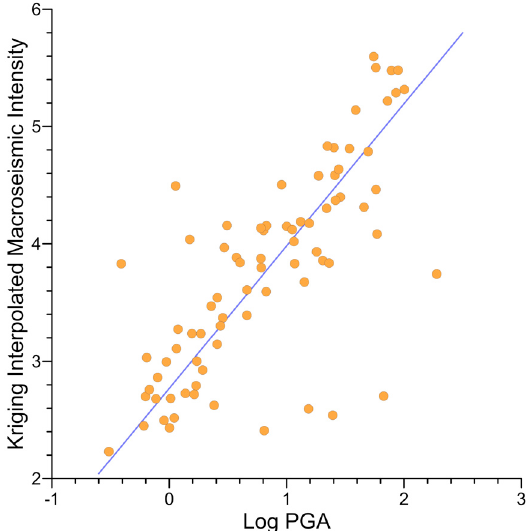
Figure 6. Scatter plot of logPGA values versus corre- sponding filtered macroseismic intensities (orange dots). The correlation coefficient is 0.74. The blue line is the Tukey medians fit.